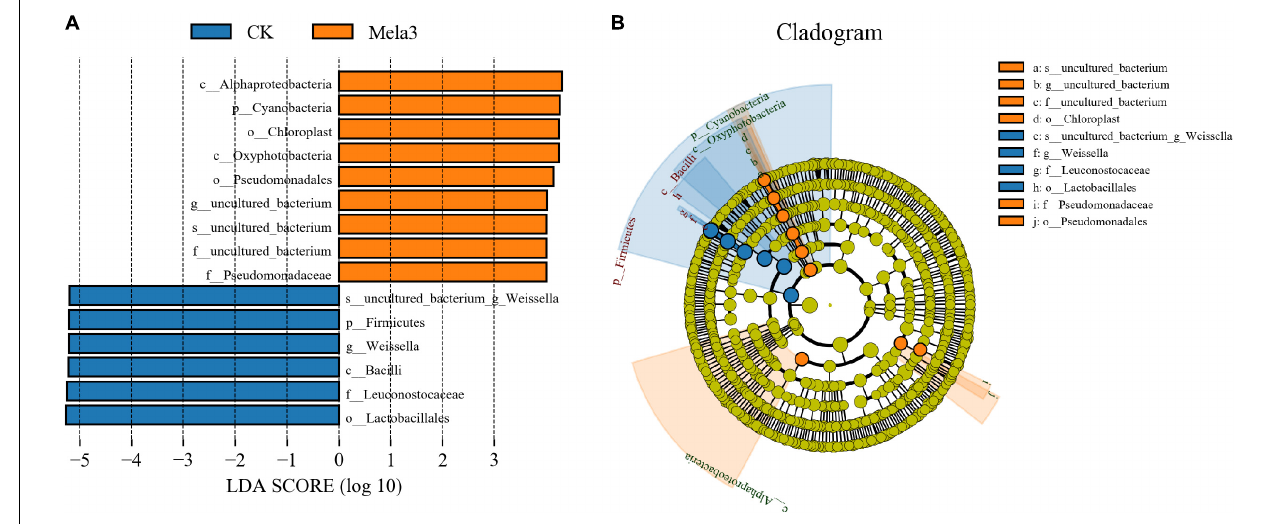
FIGURE 4 | Comparison of microbial variations using the LEfSe online tool for stylo silage supplemented with melatonin ( n = 3).